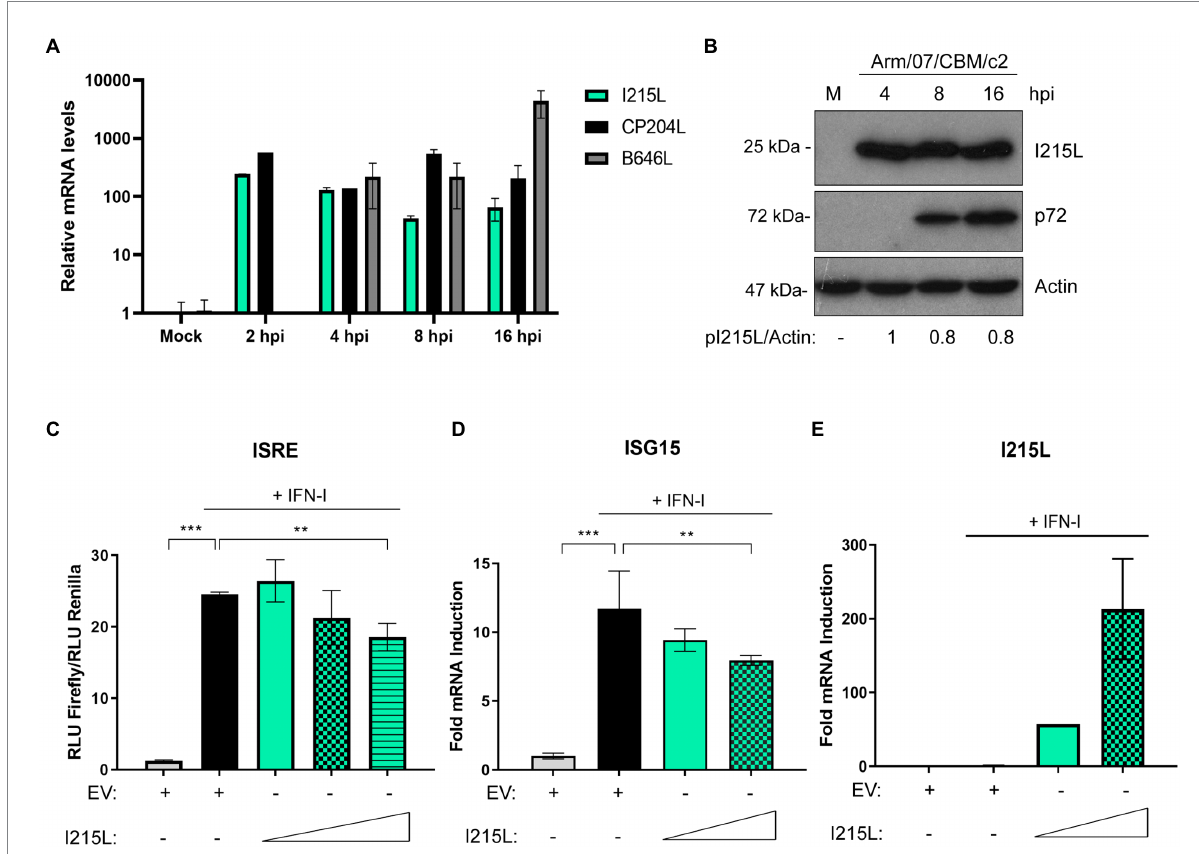
FIGURE 1 ASFV protein I215L inhibits IFN-I signaling pathway. (A) I215L transcripts were detected in mock-infected or infected PAM cells by qRT-PCR. PAMs were mock-infected or infected with the virulent Arm/07/CBM/c2 ASFV strain (2 PFU/cell) and collected at 2, 4, 8, or 16 h post-infection for mRNA extraction. As a control of an early-late and late viral gene expression, CP204L and B646L mRNA were measured, respectively. (B) I215L gene encodes for an early protein detected from 4 hpi by Western blot. Arm/07/CBM/c2 infected PAMs (2 PFU/cell) were collected at 4, 8, or 16 hpi, lysed in RIPA buffer and analyzed by Western blot. Antibodies against ASFV-pI215L, p72 (ASFV late protein) and actin were used. pI215L levels were quantified according with their actin levels and relativized to the 4 hpi sample by using ImageJ. (C) ISRE-luciferase reporter experiment was performed in HEK-293 cells transfected with empty vector control (EV) or with increasing concentrations of I215L (0.3, 1, or 3 μ g/1 × 10 6 cells) in absence or in presence of IFN-I (500 U/mL). Graph represents the means of the Firefly luciferase RLU (Relative Luminiscence Units) values divided by its Renilla luciferase RLU values from biological triplicates. Obtained values were relativized against the untreated EV transfected sample. (D) ISG15 mRNA levels were analyzed in COS-1 cells transfected with EV or increasing concentrations of pI215L (0.5 or 2.5 μ g/1 × 10 6 cells) in absence or in presence of IFN-I by qRT-PCR. (E) I215L mRNA levels were amplified by qRT-PCR in the same conditions than (D) to verify the efficient I215L transcription in transfected HEK-293 cells. All data reflect mean ± SEM ( n = 3). Data were statistically analyzed by using a Student t - test (** p < 0.01; *** p <